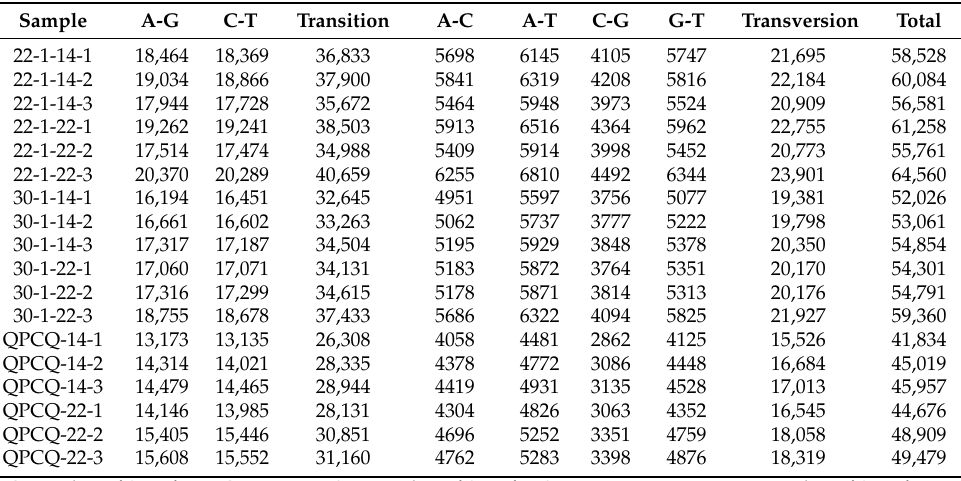
Table 1. SNP variant type